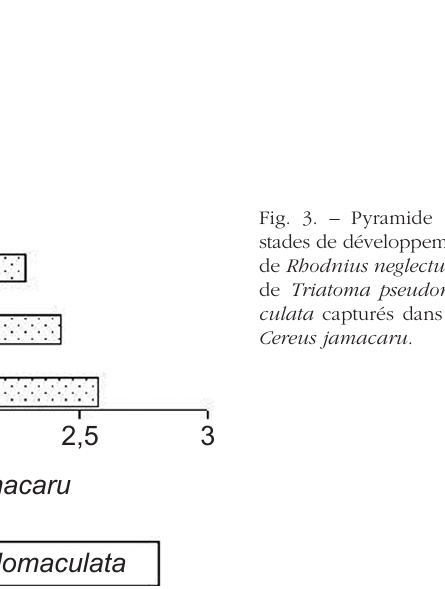
Fig. 3. – Pyramide des stades de développement de Rhodnius neglectus et de Triatoma pseudoma- culata capturés dans les Cereus jamacaru